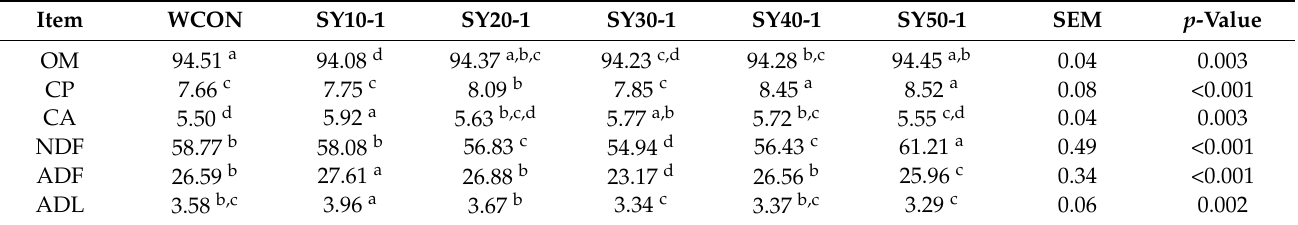
Table 8. Chemical compositions of the corn silages (% in DM).